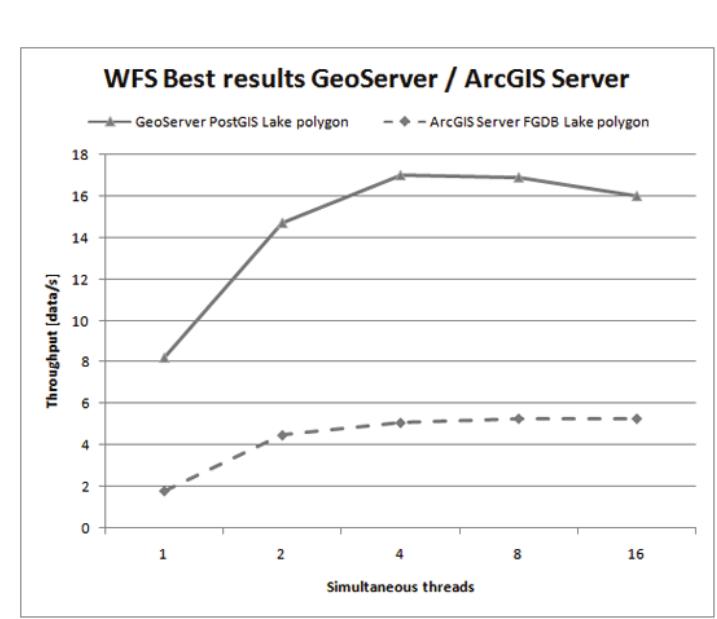
Figure 5: Comparison of best result obtained on each software implementation: GeoServer and ArcGIS